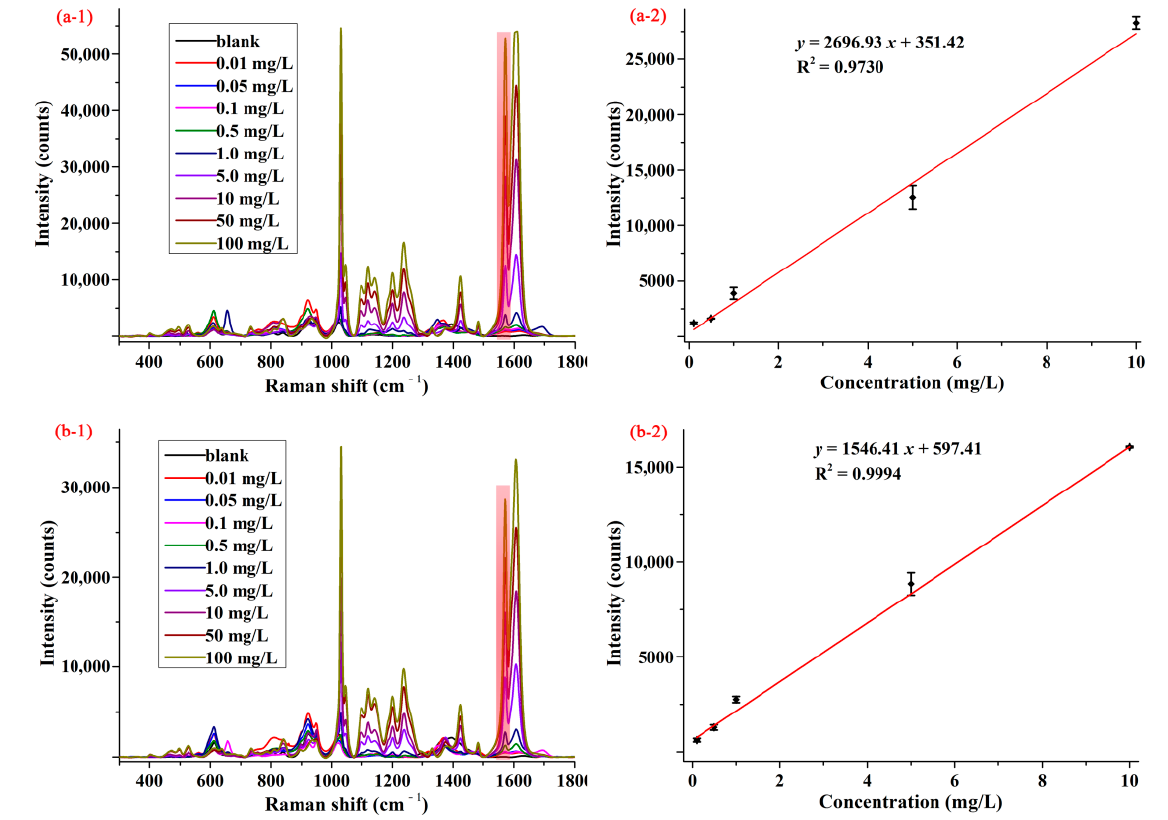
Figure 4. The average SERS spectra ( 1 ) and concentration-dependent intensity at 1572 cm − 1 ( 2 ) of pymetrozine in ( a ) apple and ( b ) cabbage extracts.